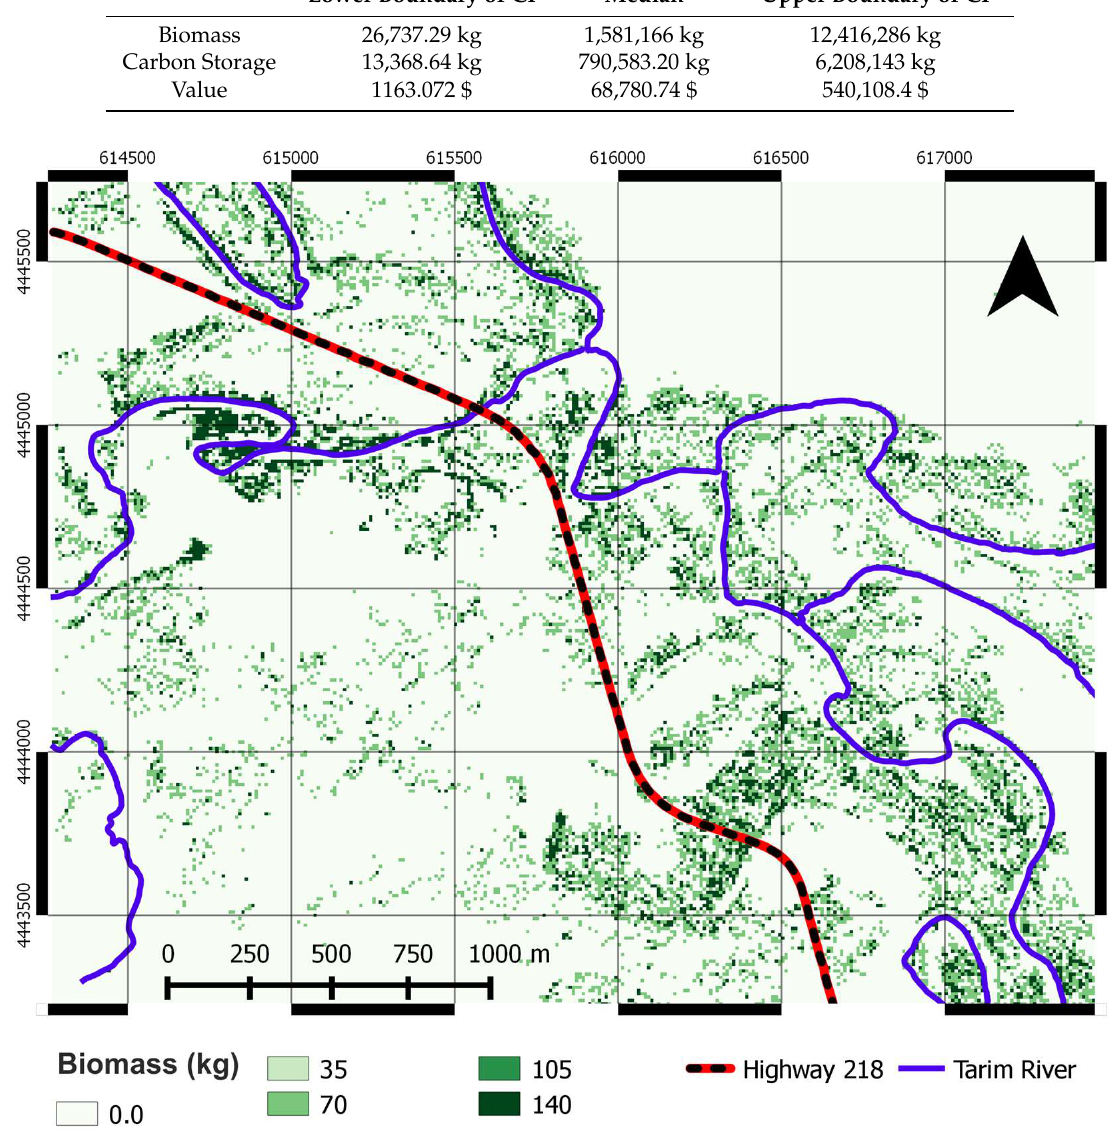
Figure 6. Spatial distribution of estimated potential biomass distribution for P. euphratica forests at Arghan in the lower reaches of the Tarim River.